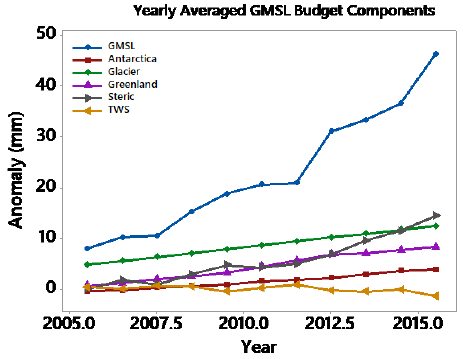
Fig. 1. Yearly averaged anomalies of observed GMSL budget compo- nents during 2005 -